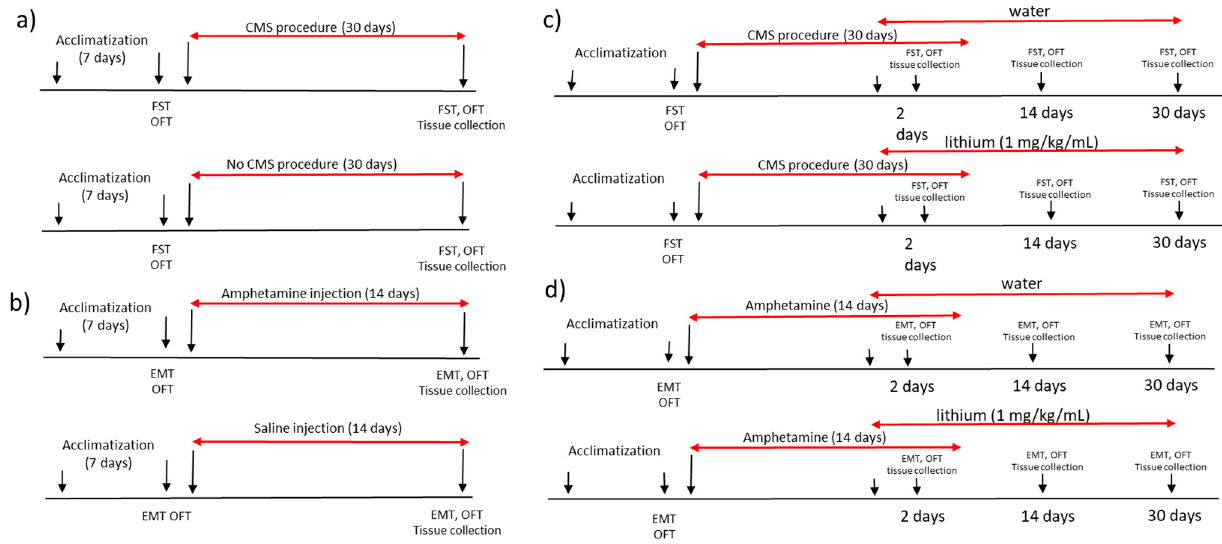
Figure 7. The experimental design of the study showing the ( a ) procedure of inducing manic-like behavior, ( b ) procedure of inducing depressive-like behavior, ( c ) lithium administration in rats with manic-like behavior and ( d ) lithium administration in animals showing depressive-like behavior. CMS—chronic mild stress protocol; EMT—elevated maze test, FST—forced swim test, OFT—open field test.